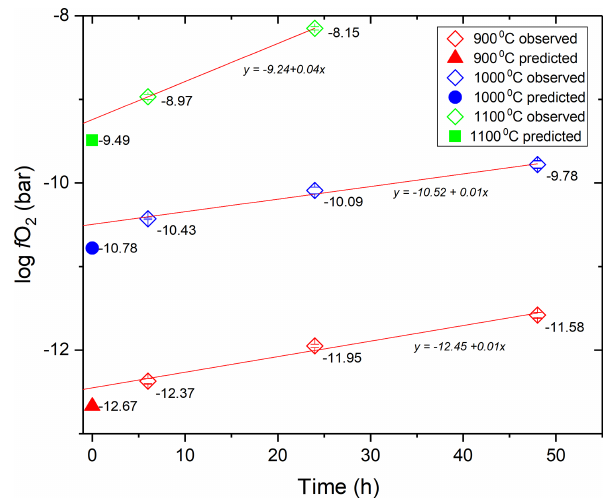
Figure 7. The results of the time series redox sensor experiments (the error bars for the observed log f O 2 values are smaller than the symbols on the